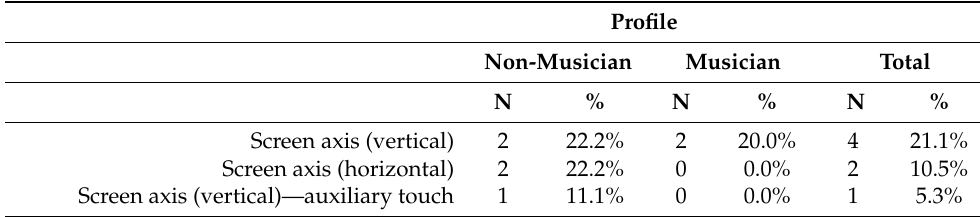
Table A15. Amplitude variation mapping (uncategorized)—stimulus